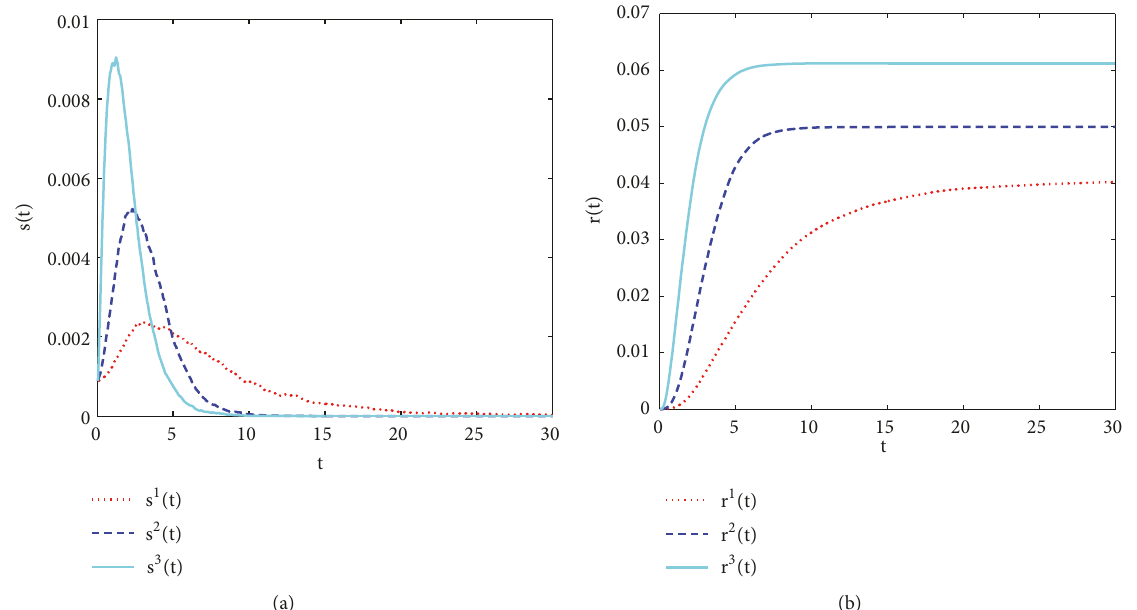
Figure 1: The time evolutions of (a) the average density of spreaders and (b) the average density of stiflers for rumor propagation with the spreading rate 𝛼 = 0.2 and the decay rate 𝛽 = 1 . From bottom to top, the spreading originates from a node with degree 1, a node with degree 16, a node with degree 71,